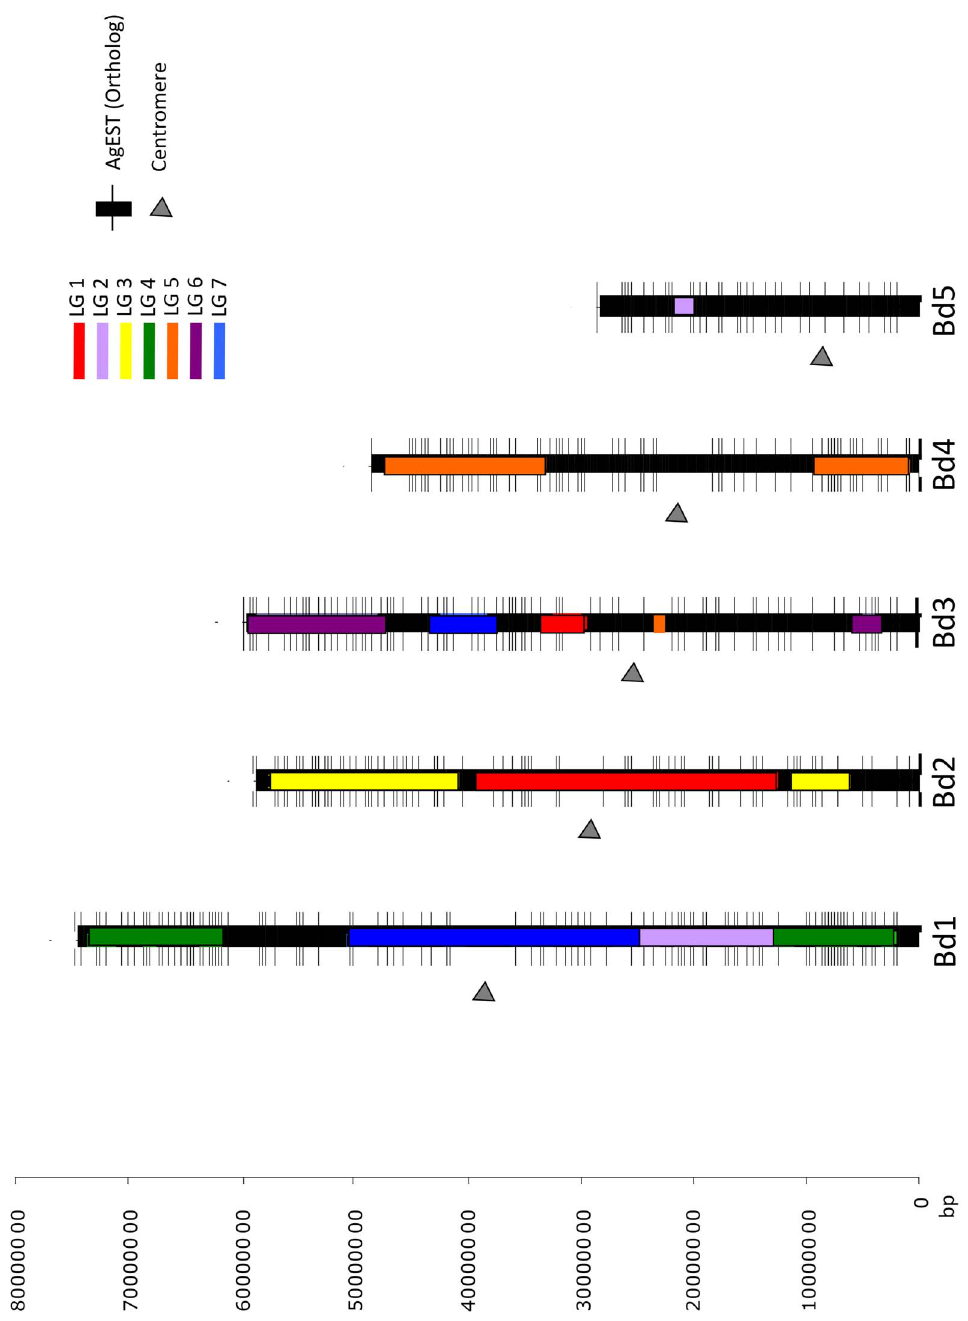
Figure 6. Creeping bentgrass ESTs orthologous to Brachypodiumdistachyon . Creeping bentgrass ESTs (AgEST) orthologous to B. distachyon genome and their location in the physical map of B. distachyon (in base pairs). Bd1, Bd2, Bd3, Bd4 and Bd5 represent the B. distachyon chromosomes (1 to 5) and horizontal lines denote the position of the 678 AgEST orthologs. The segments of a seven-color code (LGs 1–7) indicate the creeping bentgrass linkage groups that have synteny with a specific region of B. distachyon chromosomes. The arrowheads indicate the centromeric region.